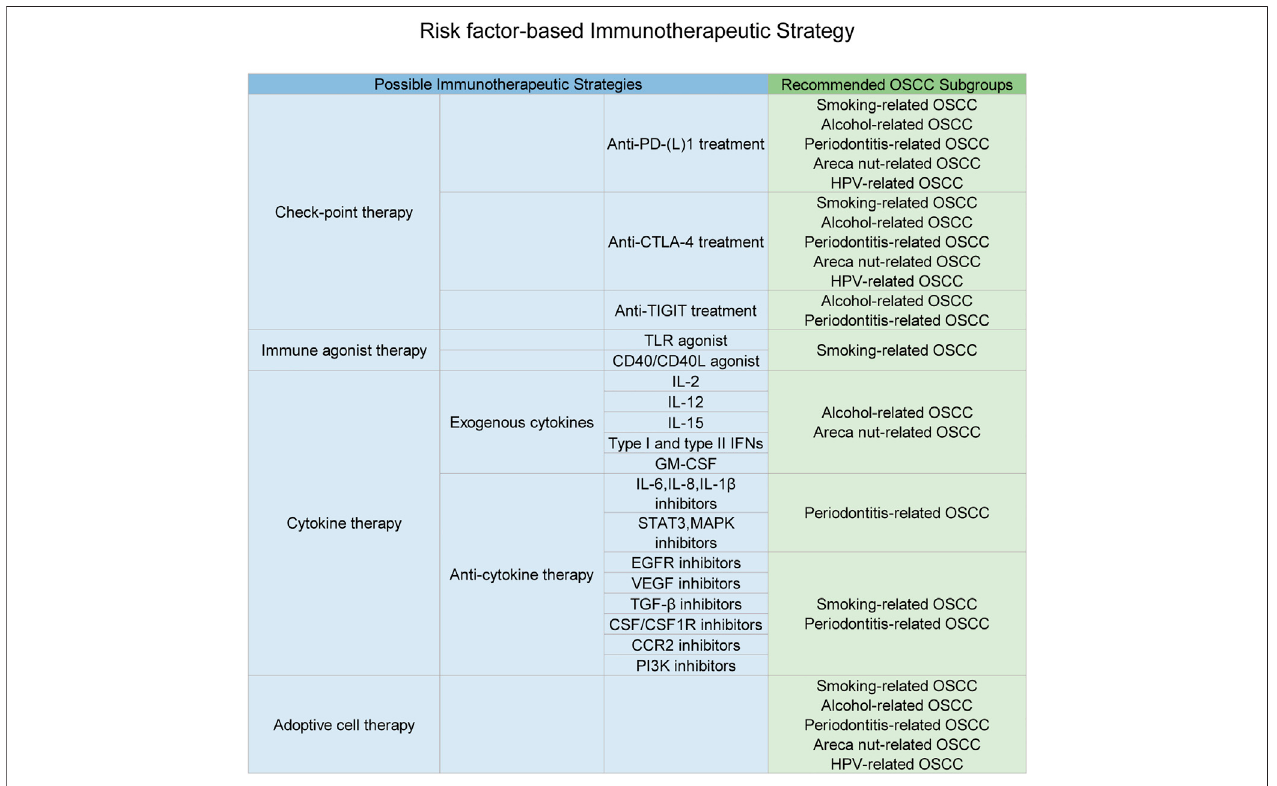
FIGURE 5 | Immunotherapeutic strategies based on the speci fi c carcinogen-related immune status. This fi gure depicts multiple types of immunotherapeutic strategiesand subsequent OSCC subgroupssuitable for each kindofstrategy.As discussed inthis manuscript, carcinogenswould result inaspeci fi caberrant immune status for OSCC patients, which just explained drug resistance and individual variations of immunotherapeutic responses. Thus, possible personalized immunotherapeutic strategies based ondifferent carcinogen-induced types ofthe OSCC localimmunestatuswere listed above and might achieveabetter clinical